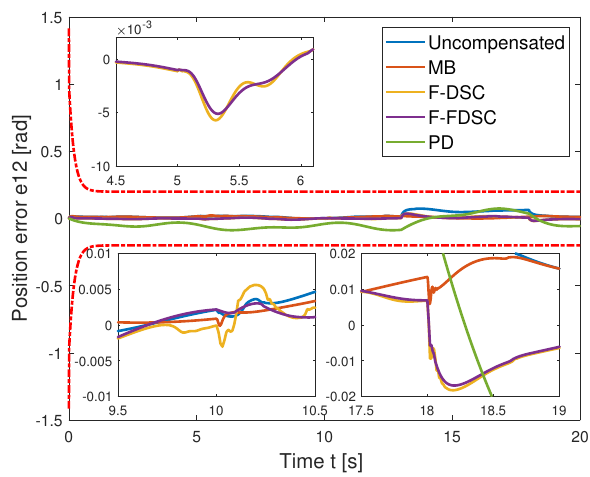
Figure 15. Position error e 12 .